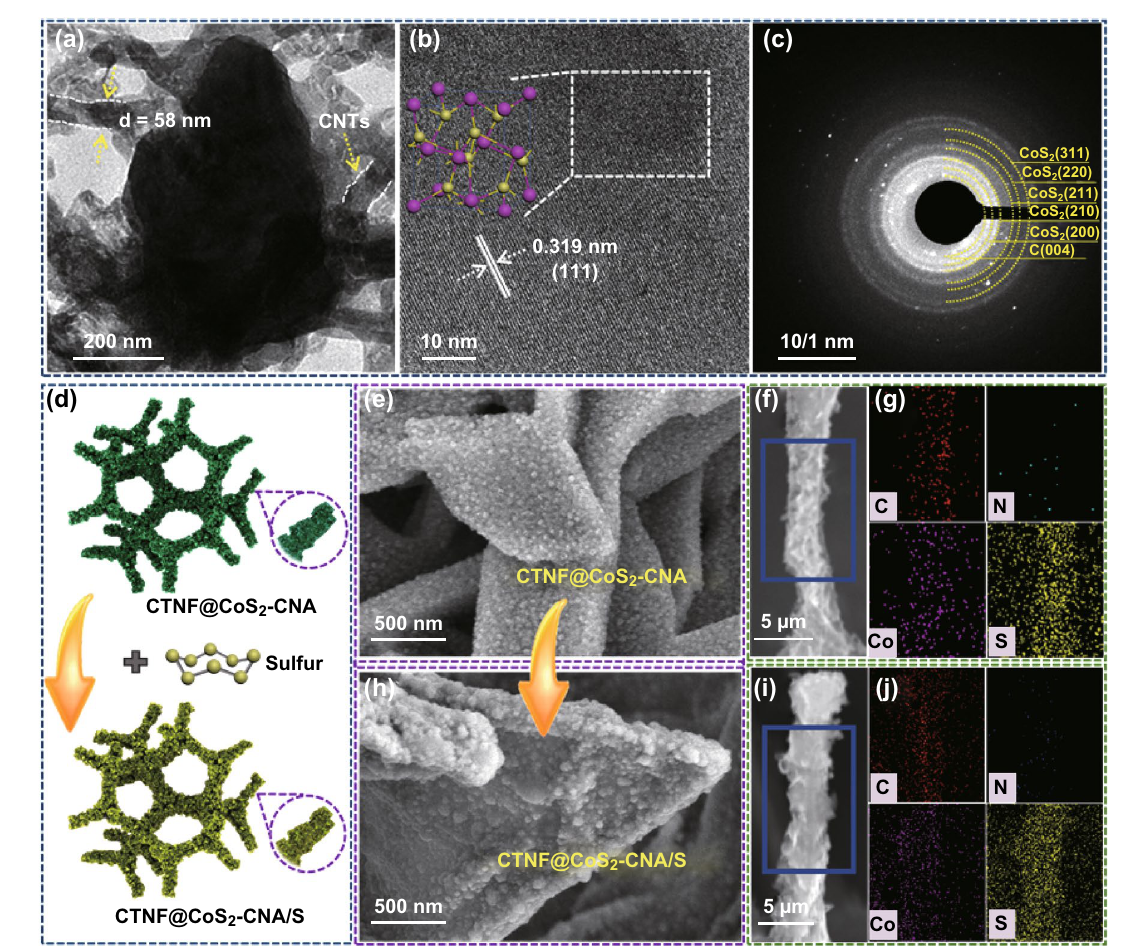
Fig. 3 a TEM images and b – c High-resolution TEM images of CTNF@CoS 2 –CNA. d The sketch map and e , h the corresponding SEM images of sulfur-loading process. f , g Elemental mapping of C, N, Co, and S elements collected from the marked area in f of CTNF@CoS 2 –CNA. i , j Elemental mapping of C, N, Co, and S elements collected from the marked area in i of CTNF@CoS 2